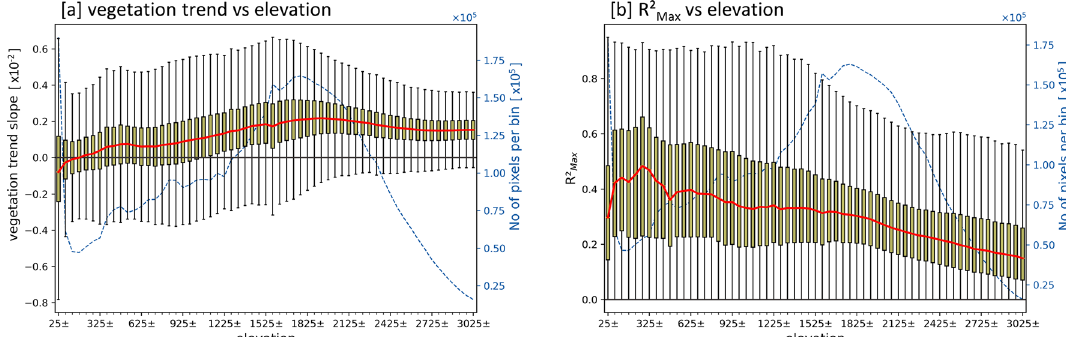
Figure 8. Altitudinal statistics for natural vegetated areas. ( a ): Trend slope of annual vegetation growth ( NDVI MEAN ∗ ) in relation to elevation. ( b ): R 2 of the most correlating meteorological parameter ( R 2 Max ) in relation to elevation. General note: per elevation bin a boxplot is shown. Red line: median per bin. Black dashed line: number of pixels per bin. A bin represents a 50 m elevation range (e.g. first bin spans from 0 to 50 m altitude). The tick labels of the x-axis represent the middle of a bin.